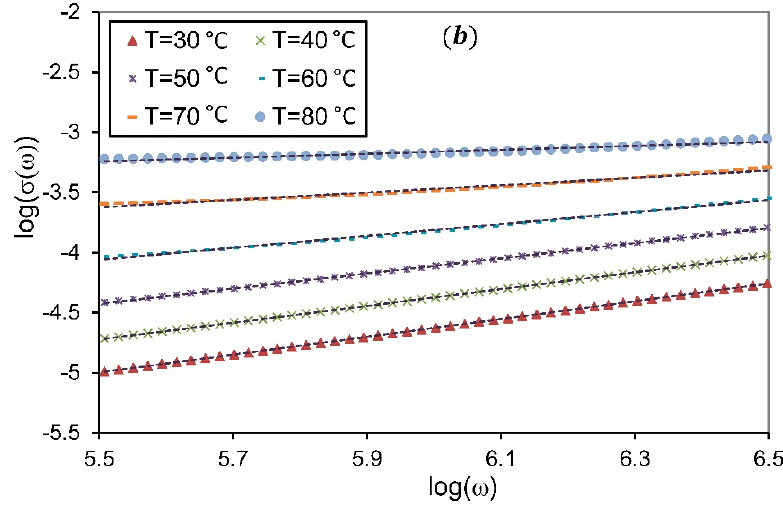
Figure 6. Plot of log𝜎(𝜔) versus log𝜔 for ( a ) pure PVA, ( b ) SPE-30, at different temperatures.